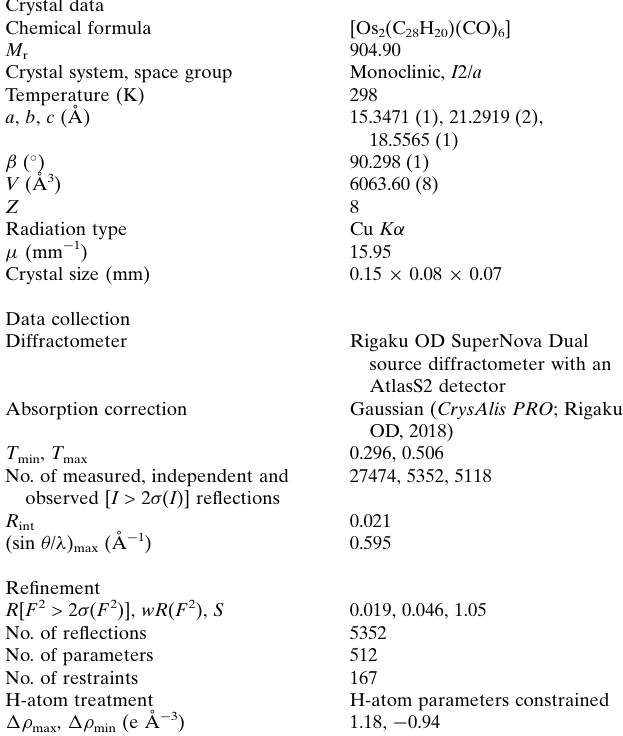
Table 2 Experimental details. Crystal data Chemical